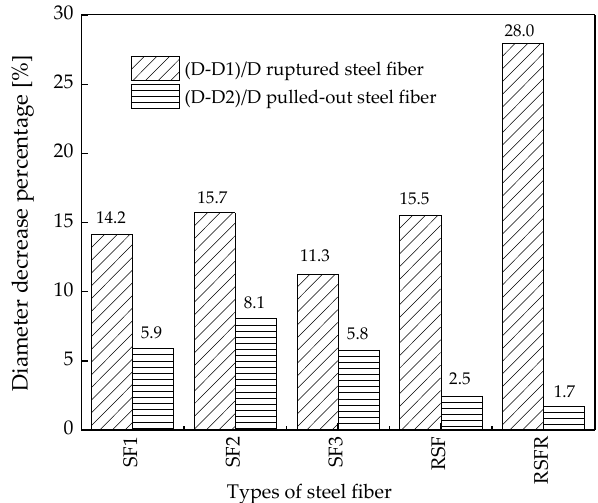
Figure 7. Percentage decrease of the diameter of steel fibers during fracture energy testing.